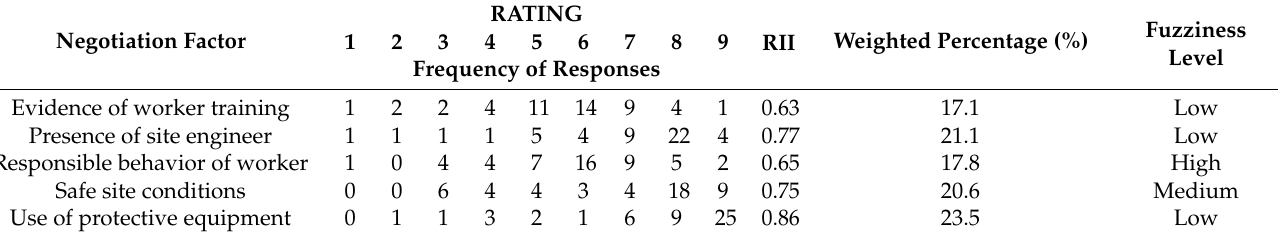
Table 6. Data, RII values, and fuzziness